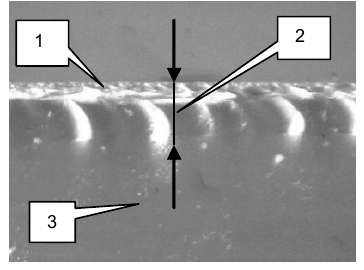
Figure 6: Fracture surface of cut glass specimen after the